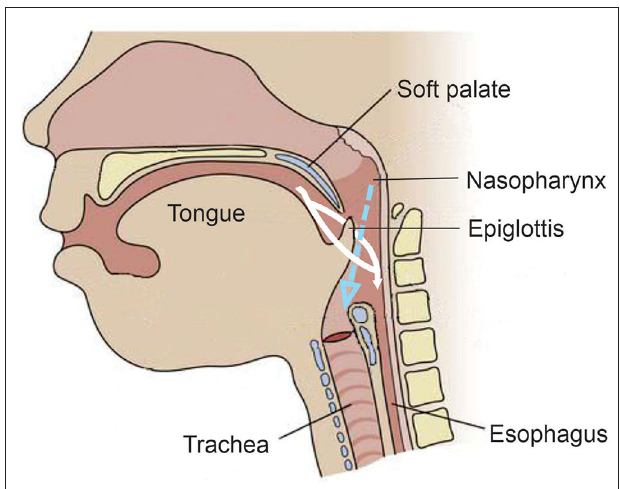
FIGURE 5 | Anatomy and physiology of the infant during feeding. Unlike the adult, the epiglottis moves upward toward the soft palate during feeding. The white indicates the fluid meal and demonstrates how it is made to go around the epiglottis and into the esophagus. The dotted blue arrow indicates the air coming from the nasal passage during the feeding and demonstrates its laminar flow into the